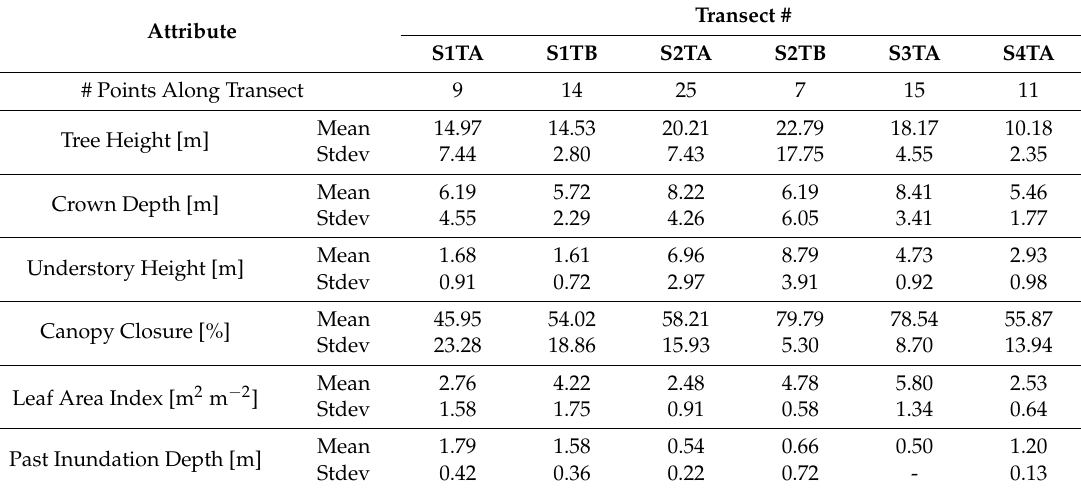
Table A5. Line transect descriptive